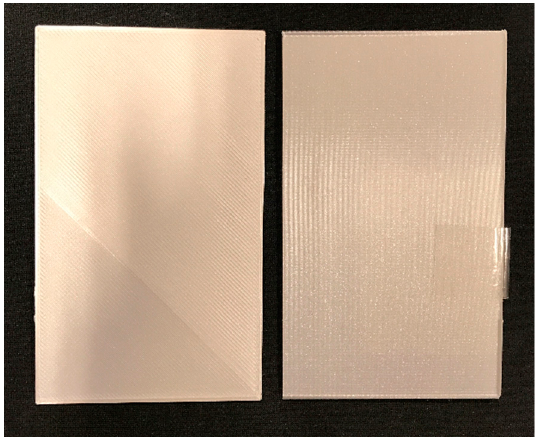
Figure 4. Left: the 3D object surface when printed in the XY plane. Right: the 3D object surface when printed in the Z plane.